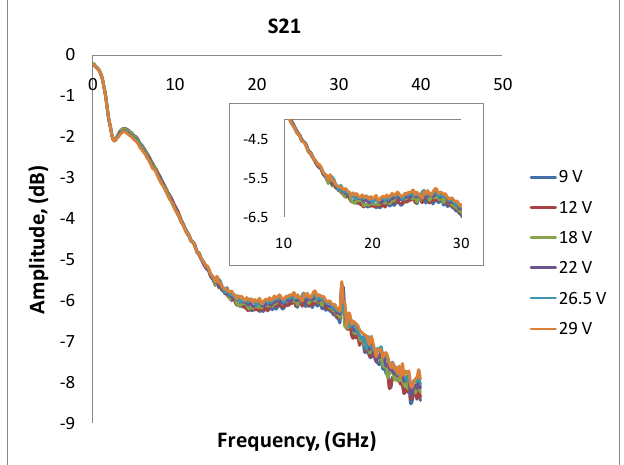
Figure 7. Measurements of transmission coefficient S21 for different applied voltages into the